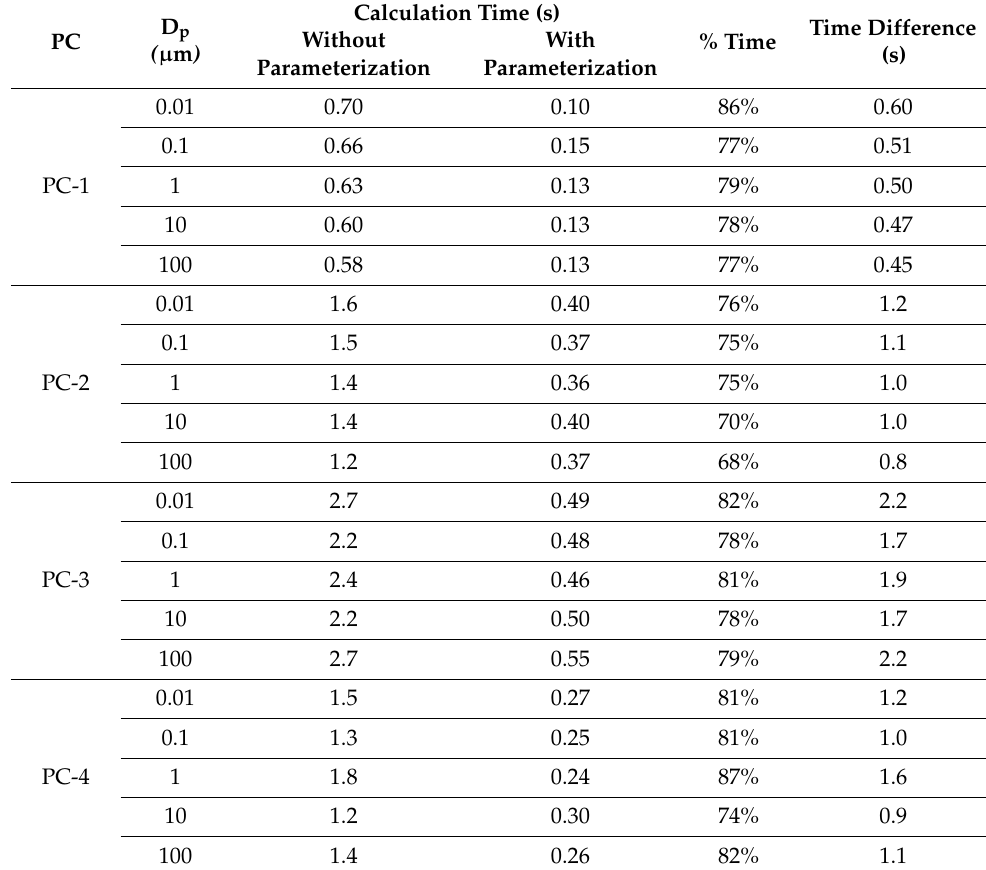
Table 3. A comparison between calculation time for unoptimized code (without parameterization) and optimized one (with parameterization) for four computers for a selected particle diameters ( D p ) for friction velocity u* = 0.1 m/s.